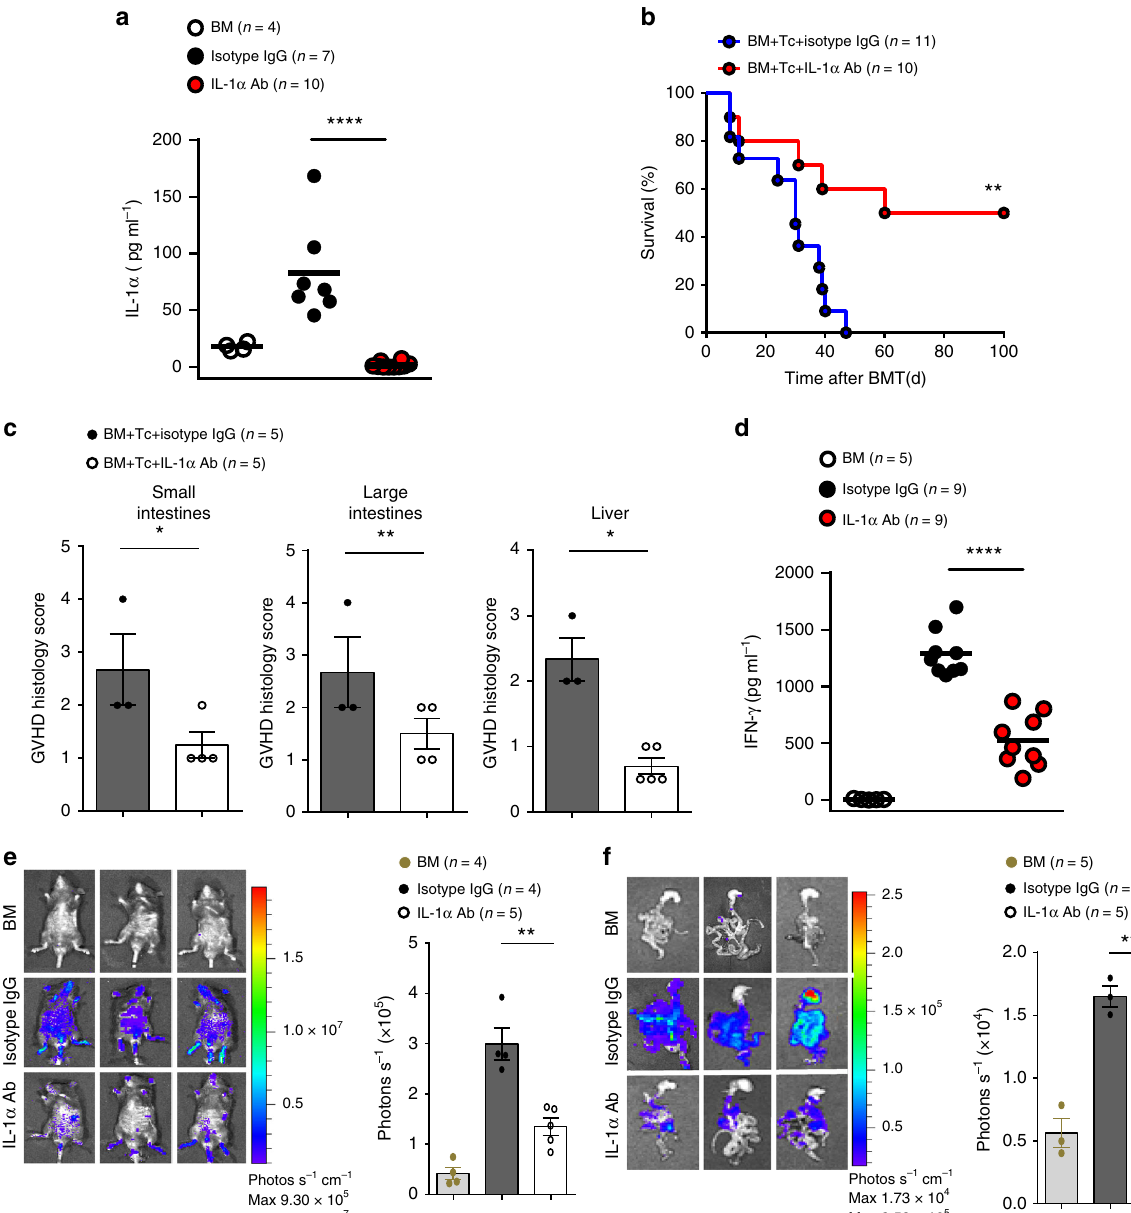
Fig. 6 Neutralizing interleukin-1 α (IL-1 α ) attenuates graft-versus-host disease (GVHD). a Levels of IL-1 α in the serum are shown from mice bone marrow (BM) receiving BALB/c BM or injected with 4 µ g per mouse anti-IL-1 α monoclonal antibody (Ab) or isotype control Ab per mouse on day − 1 and day + 1 of allogeneic hematopoietic stem cell transplantation (allo-HSCT). Scatter plot represent mean, n = 4 (BM), n = 10 (IL-1 α Ab) and n = 7 (isotype control) with results pooled from two independent experiments. **** P < 0.0001, unpaired Student ’ s t test (two-sided). b Survival of C57BL/6 recipients (BALB/c → C57BL/6 combination) is shown for a group that received BM/Tc (BM/T cell) with anti-IL-1 α monoclonal Ab or isotype control Ab. BM/Tc + isotype control Ab ( n = 11) versus BM/Tc + anti-IL-1 α monoclonal Ab ( n = 10), ** P = 0.0065. Differences in animal survival were analyzed by log-rank test. c Histological analysis of the small intestines, large intestines, and liver from anti-IL-1 α monoclonal Ab and isotype control Ab mice for GVHD severity on day 14. Data are presented as mean ± SEM. An unpaired Student ’ s t test (two-sided) was used. * P < 0.05; ** P < 0.01. d Levels of interferon- γ (IFN- γ ) in the serum of the BM/Tc + isotype control Ab ( n = 9) and BM/Tc + anti-IL-1 α monoclonal Ab recipient mice ( n = 9) on the day 5 after allo-HSCT. **** P < 0.0001. An unpaired Student ’ s t test (two-sided) was used. e Fourteen days post transplant, BM/Tc + isotype control Ab and BM/Tc + anti-IL-1 α monoclonal Ab recipients were subjected to intraperitoneal luciferin injection and whole-body bioluminescent imaging (BLI) are depicted. Average representative whole-body images, and average bioluminescence intensities ± SEM were depicted. An unpaired Student ’ s t test (two-sided) was used. ** P < 0.01 (compared with vehicle-treated controls). f Fourteen days post transplant, BM/Tc + isotype control Ab and BM/Tc + anti-IL-1 α monoclonal Ab recipients were subjected to intraperitoneal luciferin injection, whole-body BLI and BLI of intestines. Average representative ex vivo organ images, and average bioluminescence intensities ± SEM were depicted. An unpaired Student ’ s t test (two-sided) was used. *** P = 0.0003 (compared with vehicle- treated